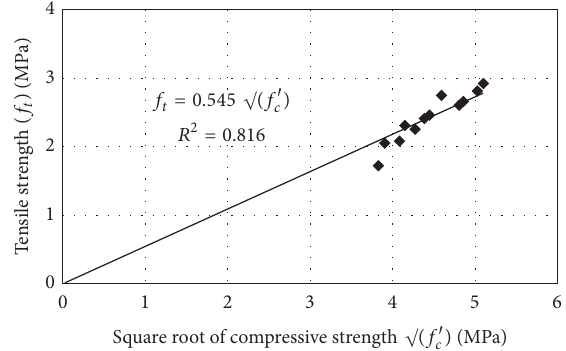
Figure 9: Relationship between tensile and compressive